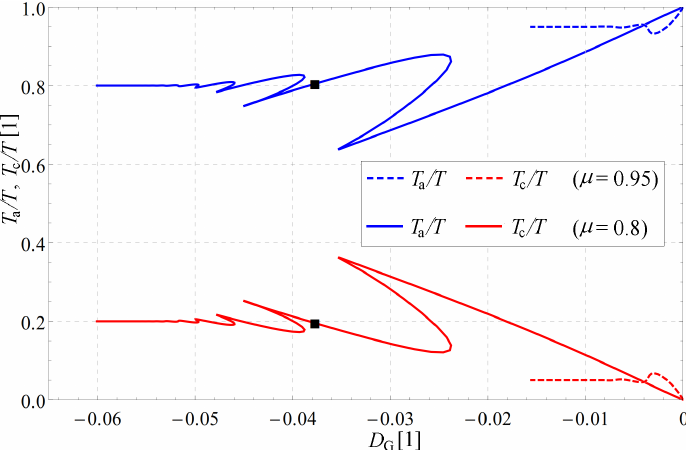
Figure 9. Ratio of constrained and admissible motion space kinetic energy with different